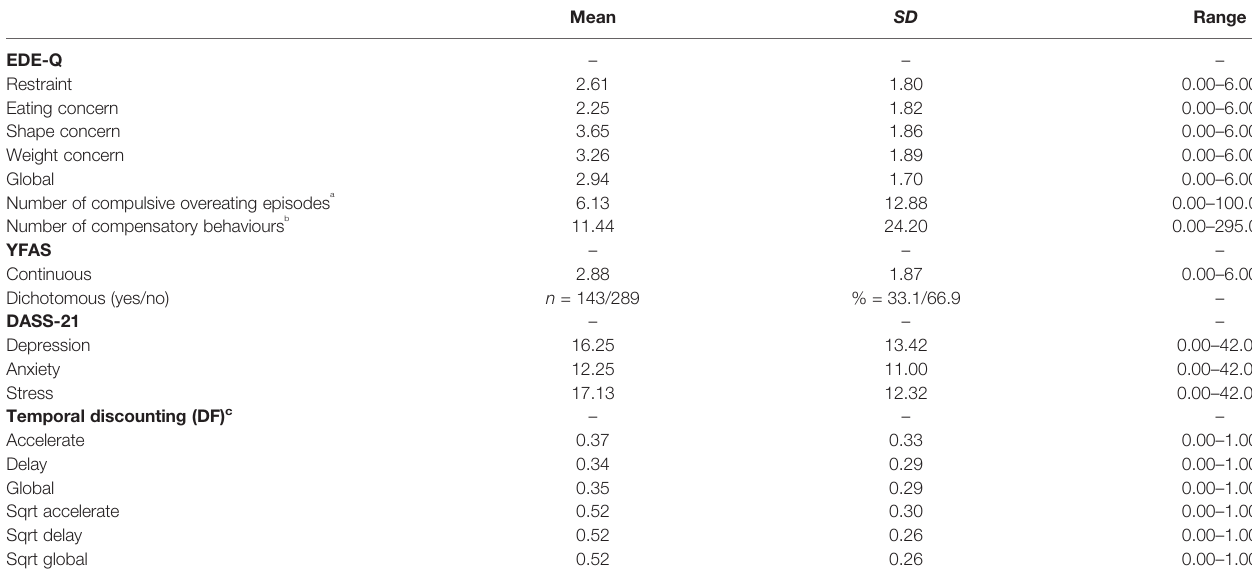
TABLE 2 | Clinical features and temporal discounting.